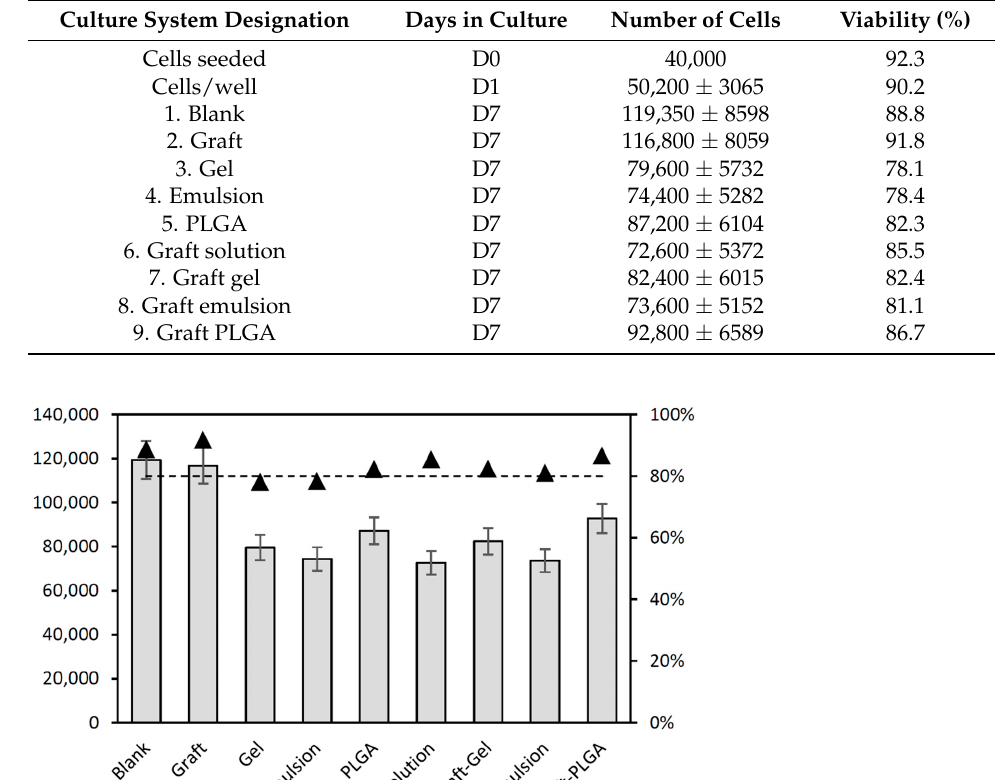
Figure 6. Bioadhesive properties of the depot delivery systems determined in a tensile test performed on bone grafts: the maximal detachment force F (N), the time taken for the peak force to decay by 90% (s), and the area under the force − time curve A (dimensionless). Table 3. Proliferation rates and viabilities of MSCs in different carriers.